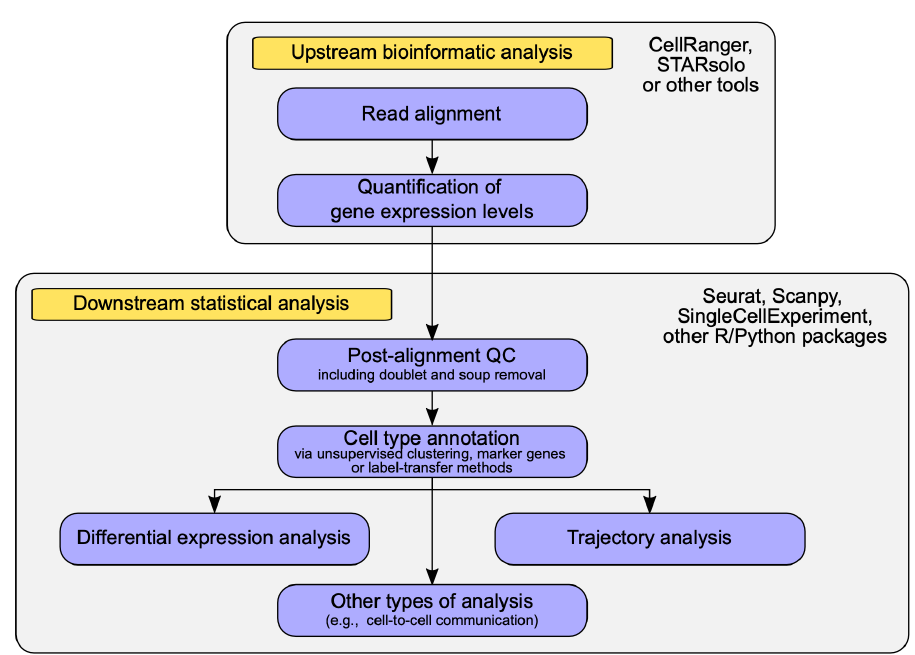
Figure 1. A diagram representing data analysis workflow for single - cell RNA sequenc ing data.